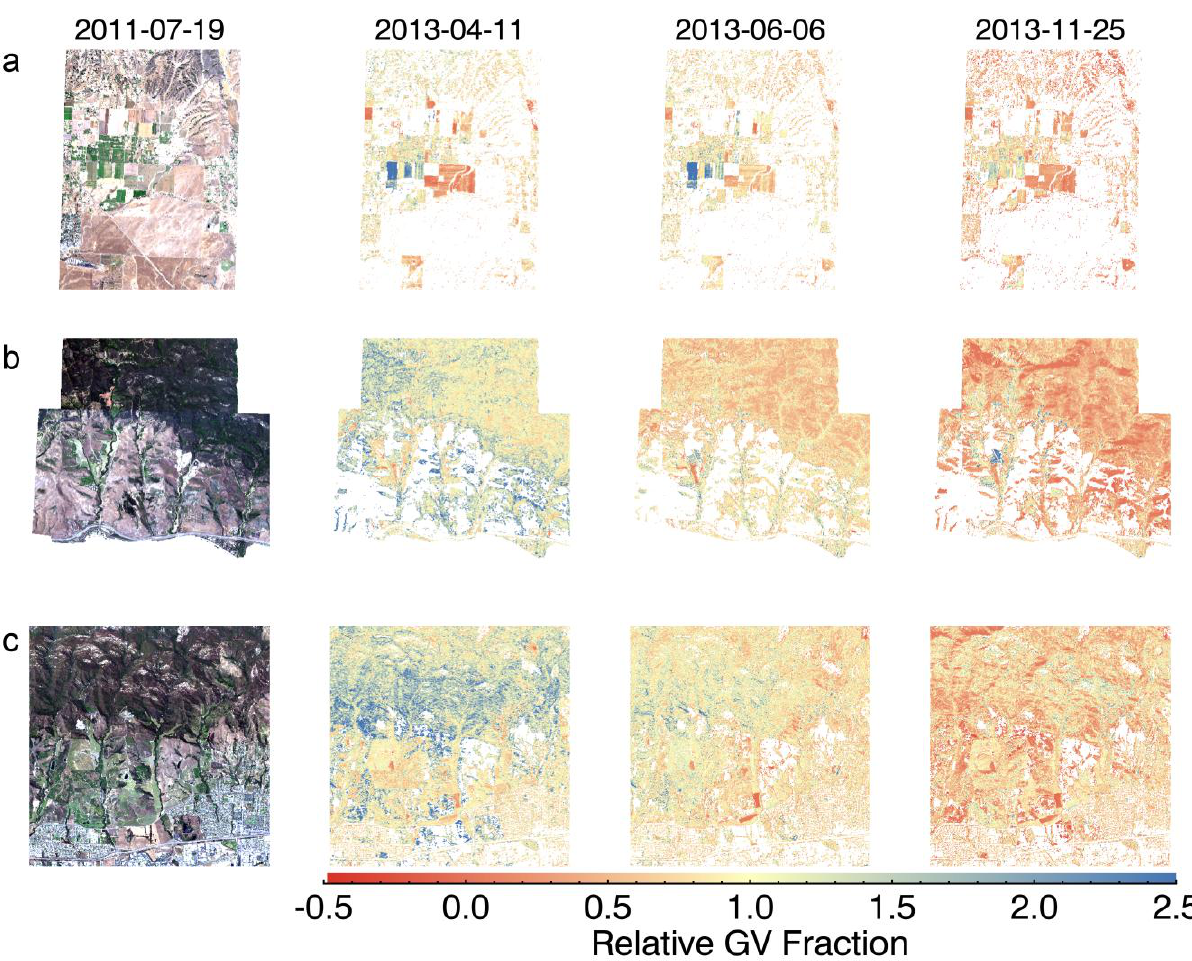
Figure 5. Relative GV fraction for dates in 2013. The areas shown are subsets of the study area shown in Figure 4: ( a ) Agriculture in the Santa Ynez valley; ( b ) chaparral (top-right of subset) and coastal sage scrub and grasslands (bottom-left of subset); ( c ) the fire scar of the 2008 Gap fire (top of subset) and agriculture and grasslands (bottom of subset). White areas indicate pixels with an NDVI less than 0.3 in the July 2011